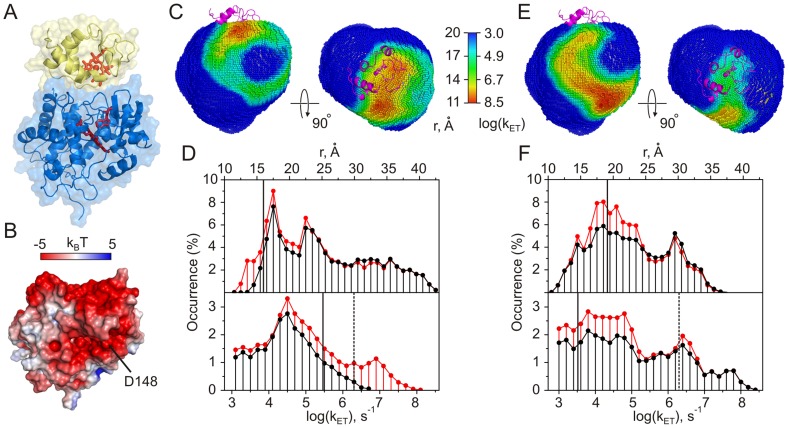
Cc-CcP.(A) Crystal structure of the complex [37]. Cc and CcP are in yellow and blue, respectively; heme groups and CcP residue W191 are shown as red sticks. (B) The molecular surface of CcP colored by the electrostatic potential (see the scale bar) calculated with APBS [68]. Low-affinity binding site is located around CcP residue D148, indicated by the arrow. Protein orientation is the same as in (A). (C), (E) Distributions of Cc centers of mass (CM) around CcP colored by the heme-W191 (C) or heme-heme (E) distances and the corresponding ET rates (see the scale bar). The left view is in the same orientation as in (A). The right view is obtained by rotation around the horizontal axis as indicated. Cc in the crystallographic orientation is shown as magenta cartoon. See Supplementary Videos S1 and S2 for an expanded view of (C) and (E), respectively. (D), (F) Distributions of the intermolecular heme-W191 (D) or heme-heme (F) distances (top) and the corresponding ET rates (bottom). Red and black traces are the distributions for the binary and ternary complexes, respectively. Solid vertical lines indicate the heme-W191 (D) or heme-heme (F) distance in the X-ray structure of the complex (top) and the corresponding ET rates (bottom). Dashed lines denote the largest experimentally measured ET rate in the Cc-CcP complex [41]. All molecular graphics were prepared with PyMOL [69].